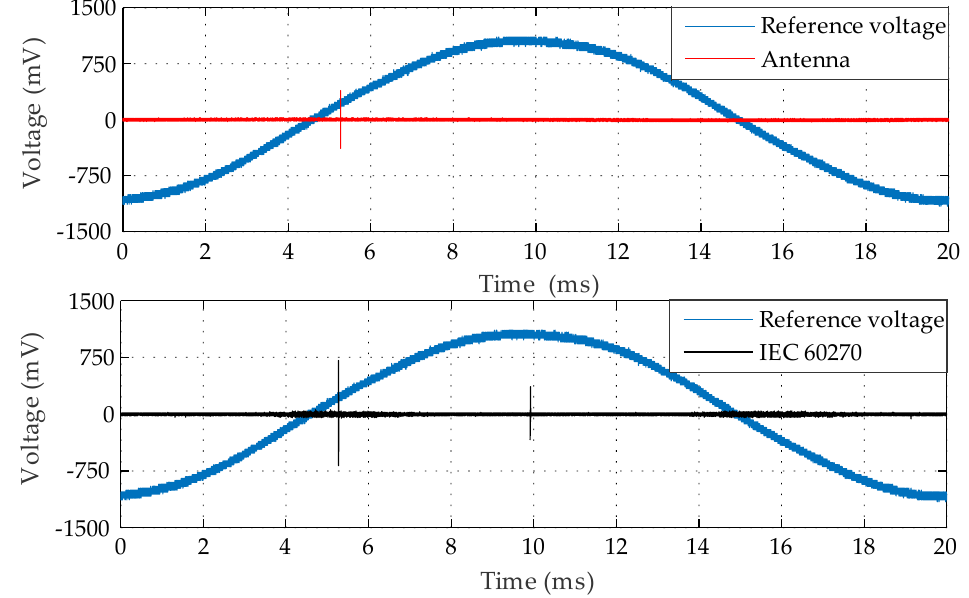
Figure 17. PD and corona pulses for point ‐ to ‐ plane configuration at 34.3 kV.